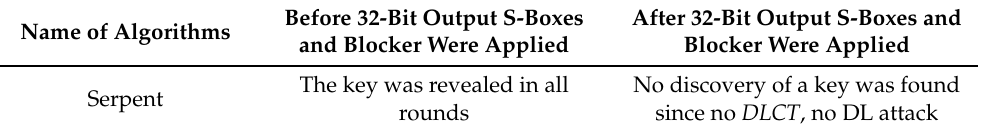
Table 20. Results of key discovery before and after 32-bit output S-Boxes and Blocker were